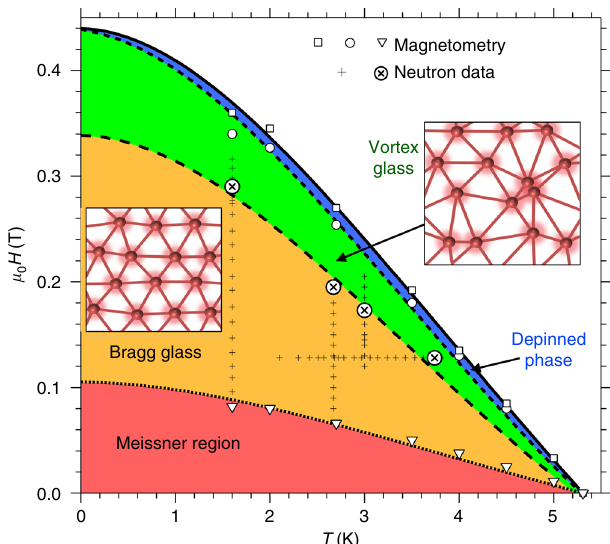
Fig. 1 Phase diagram. Vortex phase diagram for our vanadium single crystal from magnetometry and neutron scattering experiments. Superconductivity appears below the upper critical fi eld B c2 ( T ) (squares and solid line), with vortices forming between B c2 ( T ) and the lower critical fi eld B c1 ( T ) (triangles and dotted line). The critical current j c is observed to collapse in a region close to B c2 ( T ) (circles and short-dashed line). This collapse indicates that vortices are detaching from their pins. Vortex correlations are probed directly by neutron scattering. Plus signs mark the temperatures and fi elds where neutron scattering data were collected. The disappearance of neutron diffraction peaks (crosses in circles) marks the vortex order- disorder transition H dis ( T ). Short-dashed and long-dashed lines are fi ts based on different types of Lindemann criteria 23 described in the text. The insets schematically illustrate the vortex phases either side of the order- disorder line. Intriguingly, the peak effect is not located at the order- disorder line. Instead it is observed close to the depinning